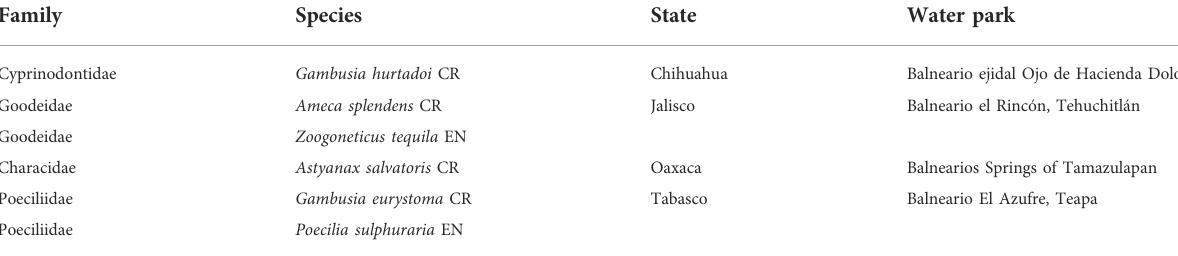
TABLE 3 List of CR + species inhabiting water parks. Family